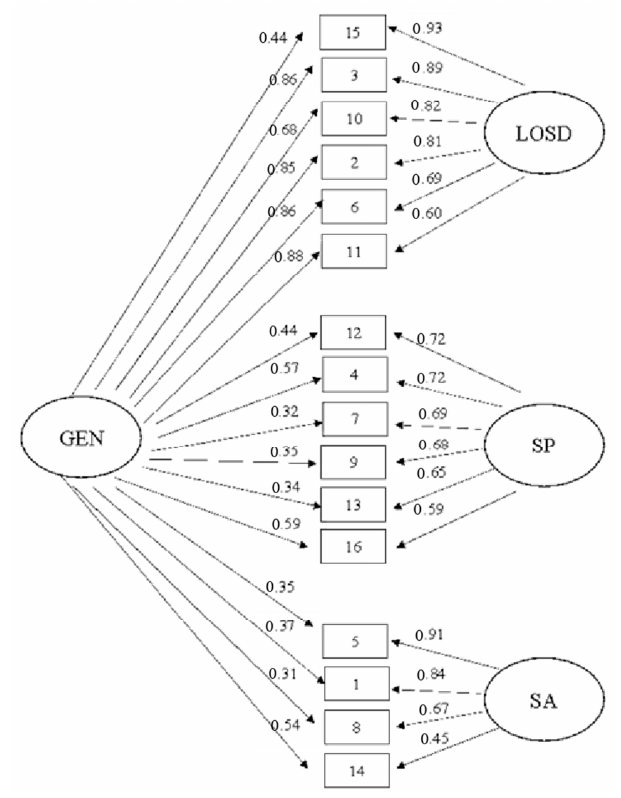
Figure 1. Bifactor measurement model of Italian version of the GRAT–RS (GEN: general factor; LOSD: lack of a sense of deprivation specific factor; SP: simple pleasures specific factor; SA: social appreciation specific